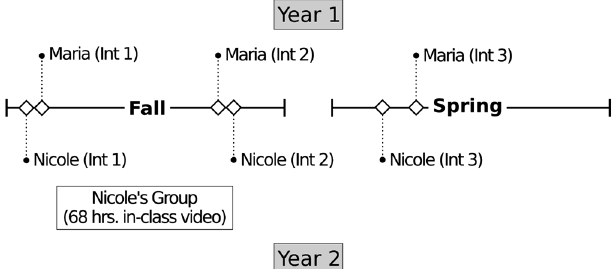
FIG. 3. The timeline of data collection for the case studies presented in this paper, Nicole and Maria. Both students took the BLiSS Physics course in the fall semester and a different second semester physics course in the spring. In year 1 of this study, in- class video was recorded of focal groups working through a unit on diffusion. In year 2, focal groups were recorded throughout the entire semester. This figure represents a subset of a much larger research study that followed over 25 students across the 2